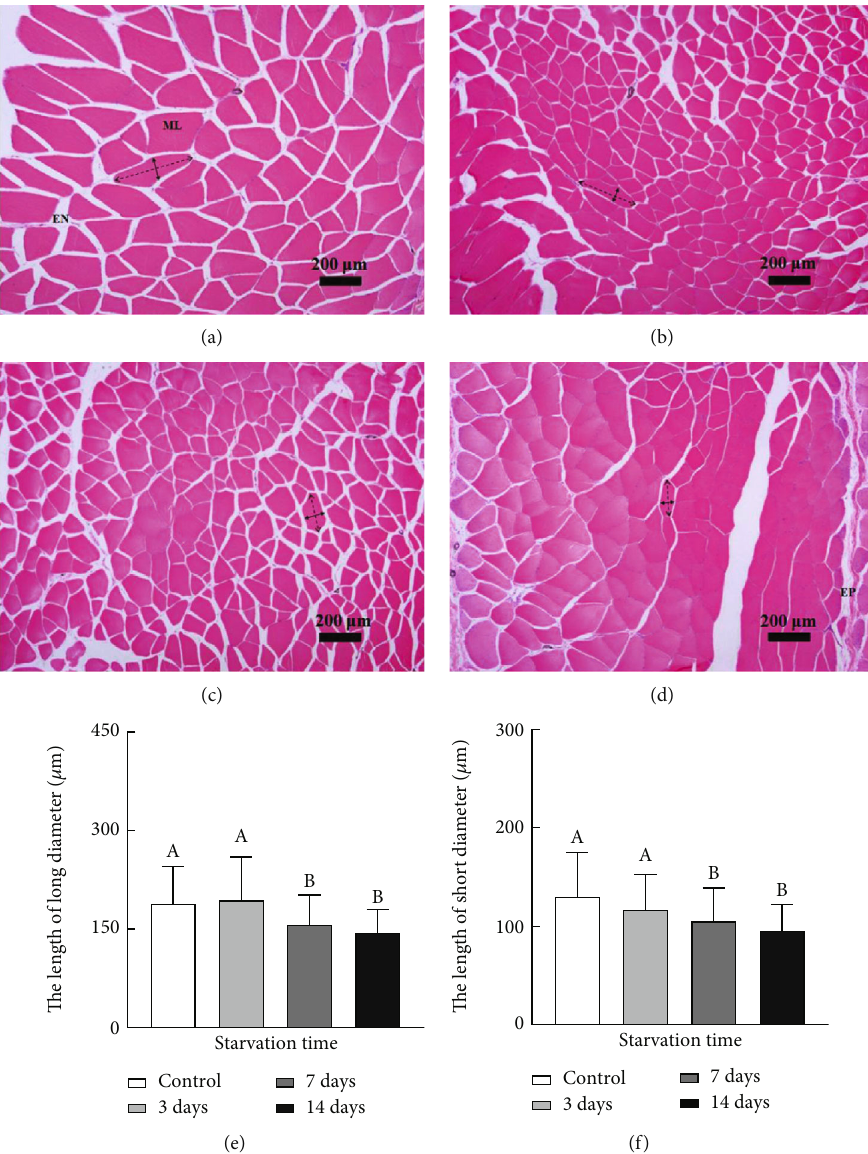
Figure 3: E ff ects of starvation on the muscle histological structure of Synechogobius hasta. Representative cross sections of muscle tissues of S. hasta fed as normal (a) and subjected to 3 (b), 7 (c), and 14 (d) days of starvation. The sections were stained with hematoxylin and eosin. MF: muscle fi ber; EN: endomysium; EP: epimysium; dotted double arrow: long diameter (maximum length of the skeletal muscle parallel to the long axis of the skeletal muscle); solid double arrow: short diameter (maximum width of the skeletal muscle perpendicular to the long diameter). Scale bar: 200 μ m. Length of long (e) and short (f) diameter in the muscle of S. hasta subjected to di ff erent starvation periods. All values were represented as means ± SD ( n = 150 ) and analyzed using the Kruskal-Wallis ANOVA with Dunn ’ s test. Di ff erent uppercase letters denote signi fi cant di ff erences ( P < 0 : 05